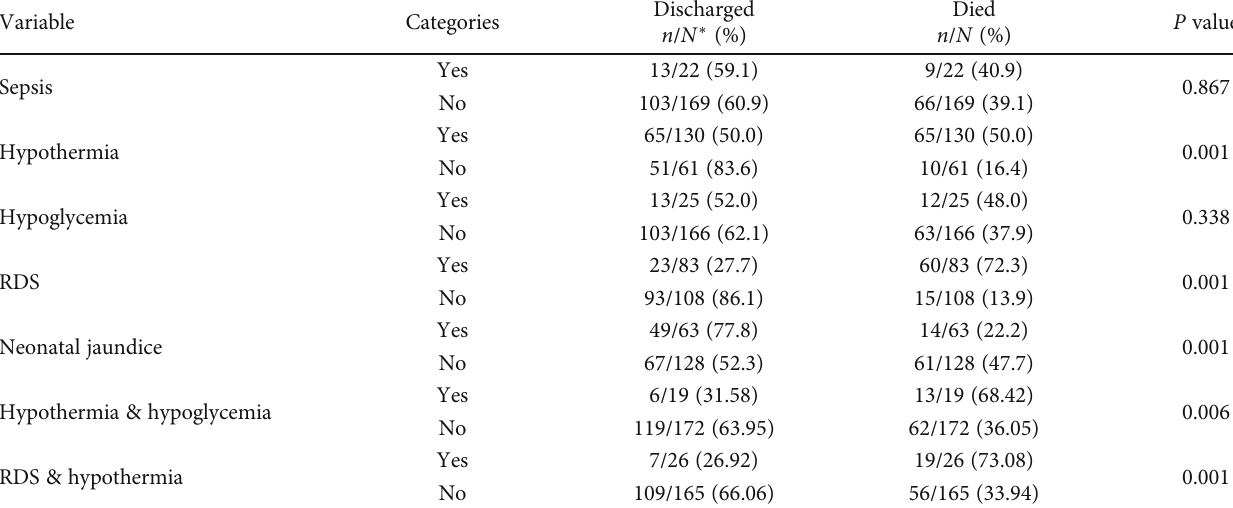
Table 4: Bivariate analysis of association between treatment outcome and comorbidities at presentation.